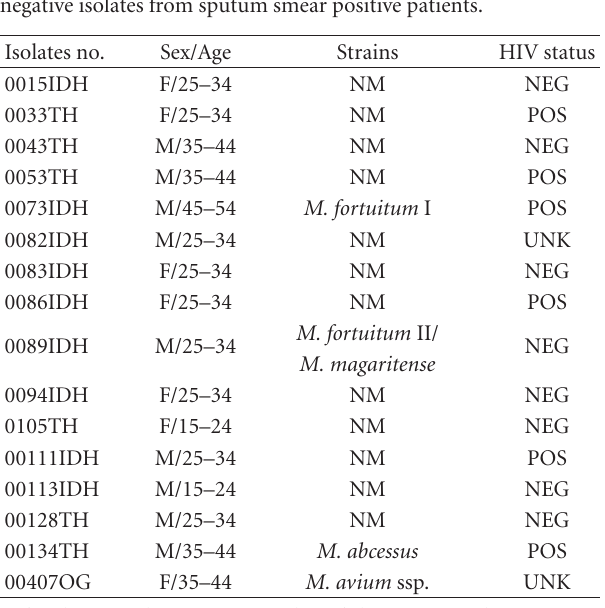
Table 2: Genotype mycobacteria identification of Capilia TB-Neo negative isolates from sputum smear positive